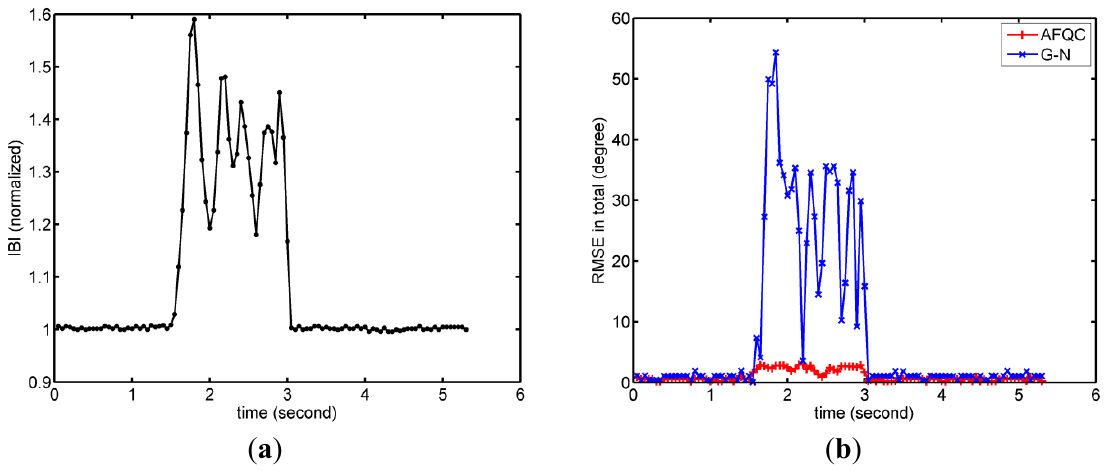
Figure 11. Typical results for estimation errors when magnetic disturbances applied. ( a ) Magnetic field magnitude. Magnetometer’s signals become variable when magnetic field is disturbed; ( b ) RMSE of AFQC and G-N.